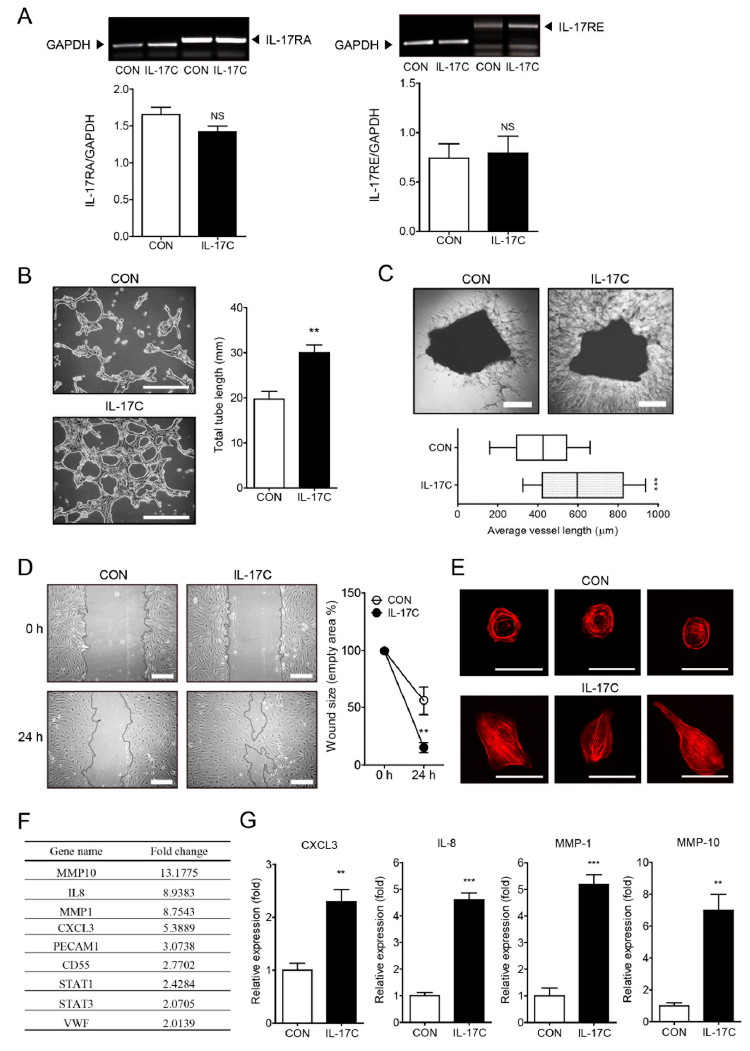
Figure 1. IL-17C stimulation promotes human intestinal microvascular endothelial cells (HIMEC) angiogenesis. ( A ) Representative bands of RT-PCR and quantitative analyses of two receptors of IL-17C, IL-17RA (( A ), left ), and IL-17RE (( A ), right ) in HIMECs treated with vehicle control or IL-17C (100 ng / mL, 3 h) are shown ( n = 3). GAPDH was used for the loading control. NS, not significant. ( B ) HIMECs were seeded into polymerized Matrigel and treated with IL-17C (100 ng / mL, 4 h) for in vitro tube formation assays (( B ), left ). Scale bar, 100 µ m. Total tube length of photos was measured using ImageJ v.1.47 software ( n = 6) (( B ), right ). Error bars, SD. ** p < 0.01 vs. the control group. ( C ) The mouse aortic ring assay was conducted to investigate ex vivo angiogenic activity of IL-17C (100 ng / mL, 14 d) (( C ), top ). Scale bar, 50 µ m. For quantification, total sprouted tube vessels of 3 independent photos from each group were measured using ImageJ v.1.47 software (( C ), bottom ). Error bars, SEM ( n = 3). *** p < 0.001 vs. the control group. ( D ) For the wound healing assays, cells were seeded in a culture plate, incubated with culture media with / without IL-17C (100 ng / mL), and scratched to create wounds. Photos were taken 24 h after wound creation (( D ), left ). Scale bar, 50 µ m. A view of representative fields from images of the wound healing assays, analyzed using ImageJ v.1.47 software (( D ), right ). Error bars, SD ( n = 6). ** p < 0.01 vs. the control group. ( E ) F-actin organization in endothelial cells determined via rhodamine-phalloidin staining ( n = 3). Scale bar, 50 µ m. ( F ) PCR microarray was performed to investigate expression levels of angiogenesis-related genes by IL-17C (100 ng / mL, 3 h) treatment in HIMECs ( n = 1). ( G ) The mRNA levels of CXCL3, IL-8, MMP-1, and MMP-10 were analyzed by qPCR at 3 h post IL-17C treatment. Error bars, SD ( n = 3). ** p < 0.01 and *** p < 0.001 vs. the control